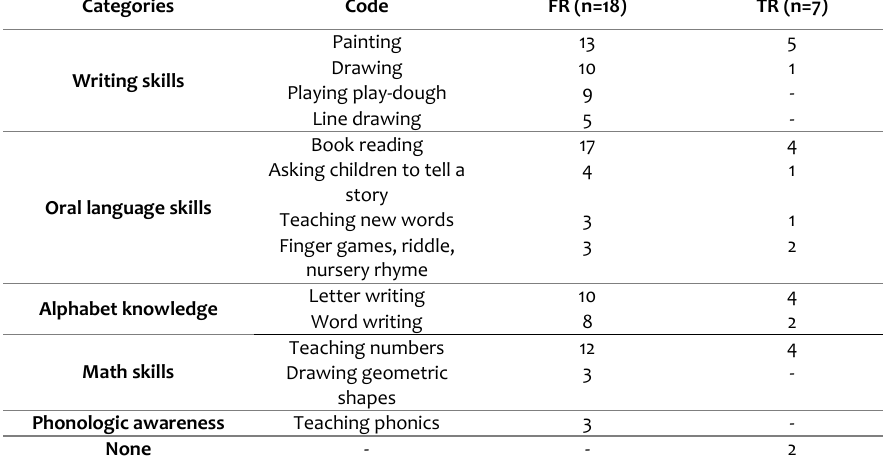
Table 3. Literacy activities implemented by mothers to support their children’s literacy skills